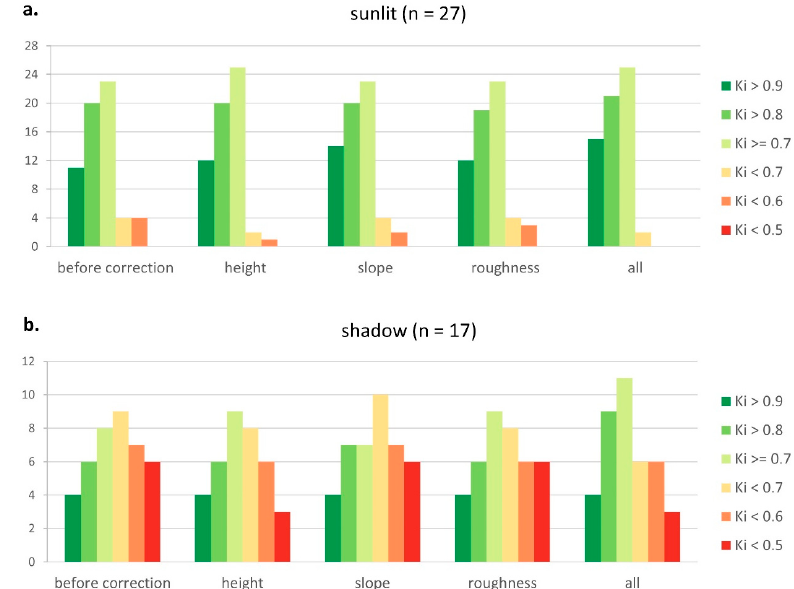
Figure 10. Cumulative histograms of class-specific kappa values listed in Tables 3 and 4 for ( a ) sunlit and ( b ) shaded areas, before post-classification correction, and after LiDAR based correction using height, slope, roughness, and all LiDAR features combined. Remember that a total of 17 shaded classes were trained and validated compared to 27 sunlit classes.